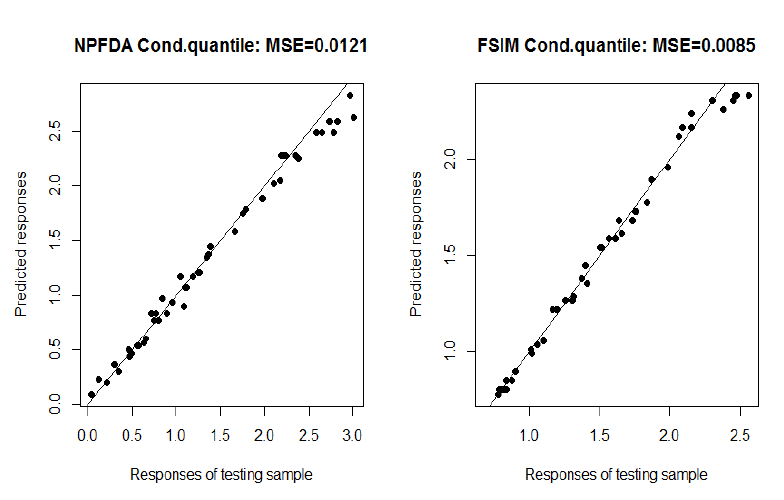
Figure 9: Prediction via the conditional quantile for complete data